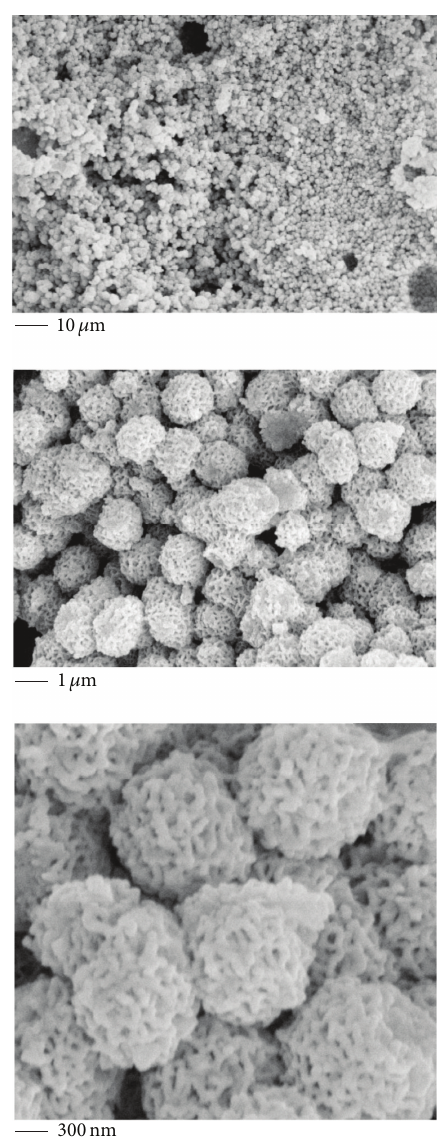
Figure 1: SEM micrograph of the obtained